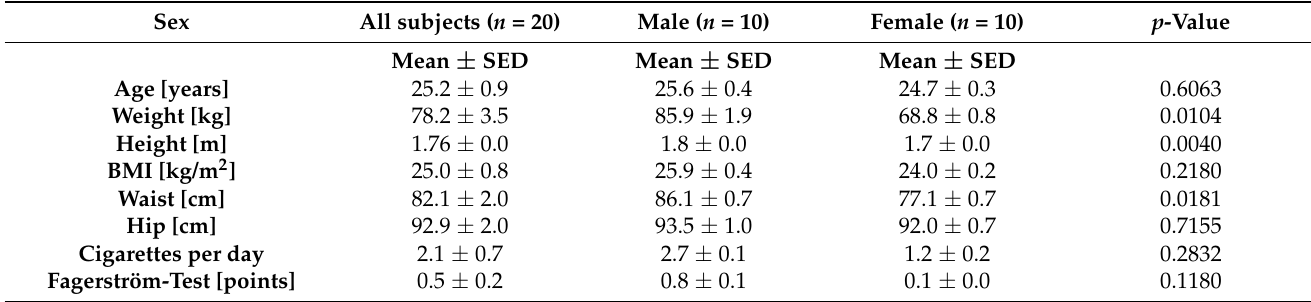
Figure 1. Flowchart of the study design. The minimum period to complete the study for one individual subject amounted 12 days including the screening day, the day for consideration, as well as the hours of each washout period. Table 1. Baseline characteristics for all analyzed 20